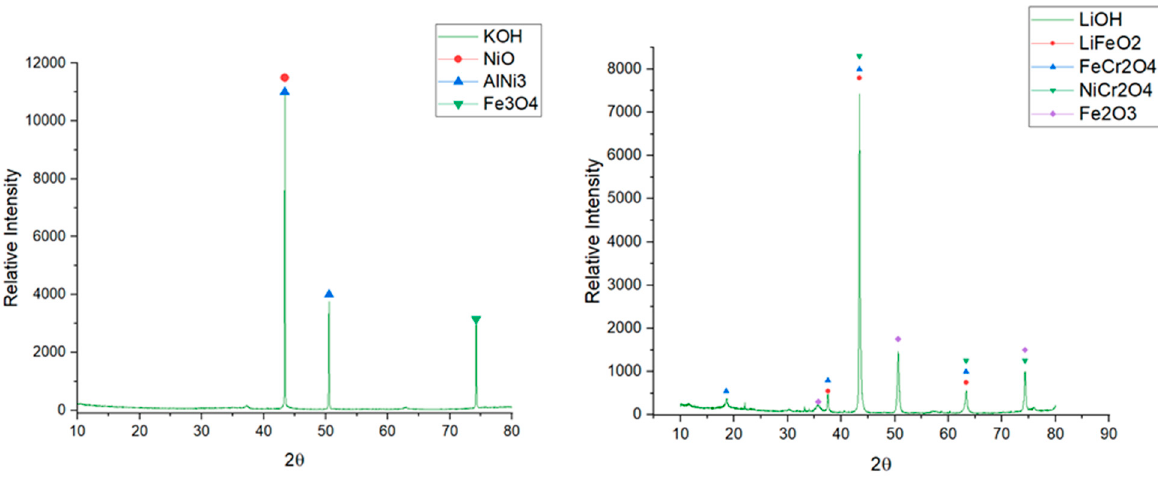
Figure 12. XRD obtained for OC4 alloy immersed in KOH ( left ) and LiOH ( right ) molten salts after 500 h.